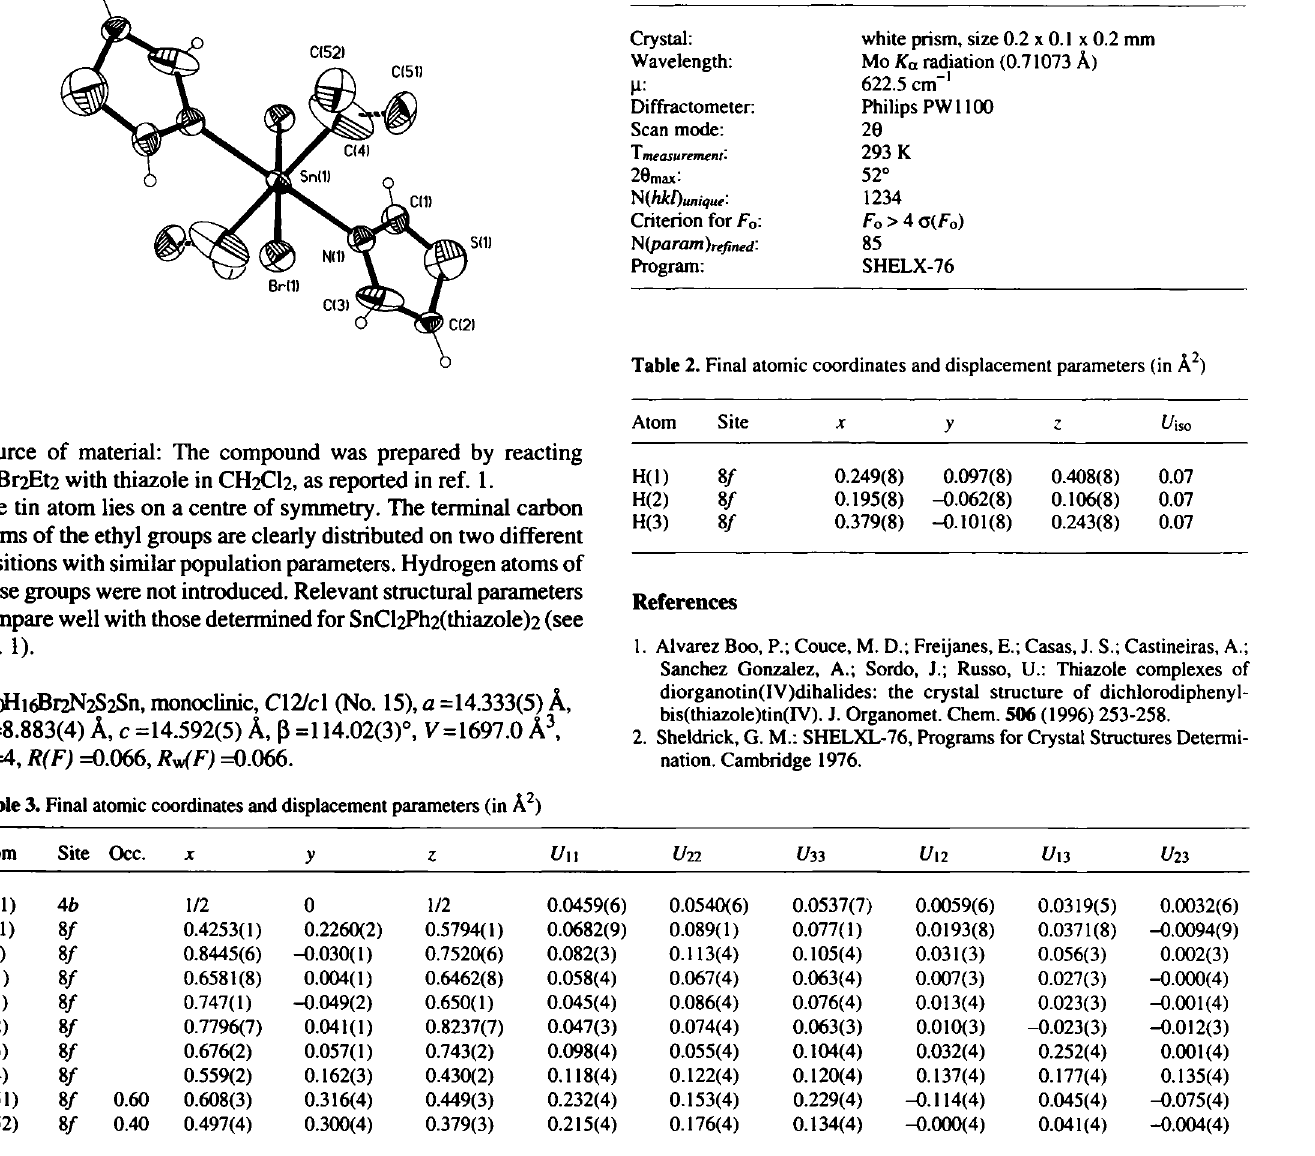
Table 1. Parameters used for the X-ray data collection